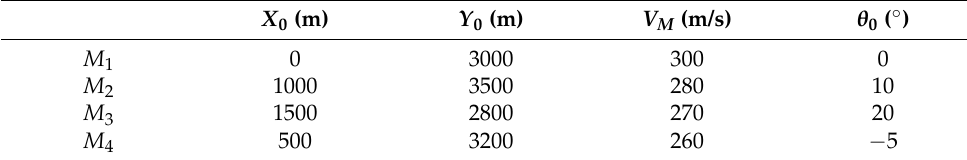
Table 2. Initial parameters of four